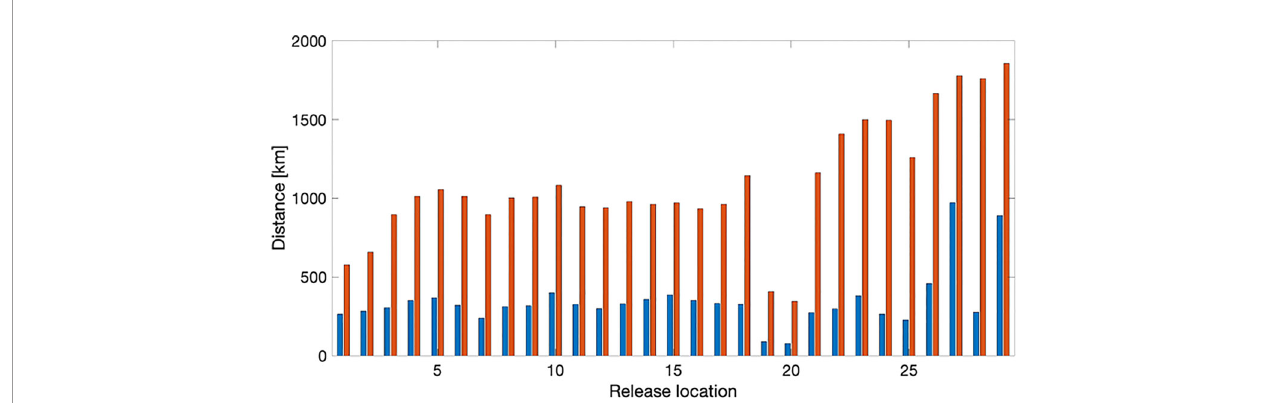
FIGURE 6 | Distances of particle dispersion away from the release locations. Blue bars represent the mean distance travelled for all particles. Red bars represent the mean distance travelled for the 10% of the particles with the longest dispersion.